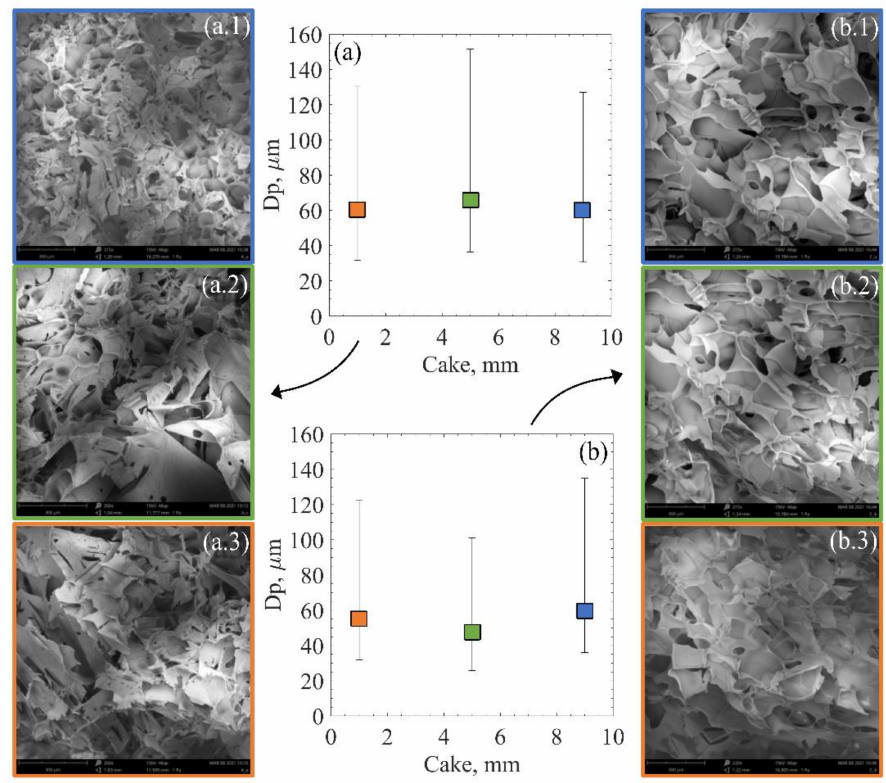
Figure 7. Average pore sizes for the resulting mannitol 5% cake after VISF tests at 271 K for ON-shelf ( a ) and OFF-shelf vials ( b ). The numbers after the test type letters ( a , b ) represent the cake section: (1) top, (2), middle and (3) bottom for the corresponding SEM images. The variability is expressed as the 3rd ( top ) and 1st ( bottom ) quartiles, as previously done for pore size data